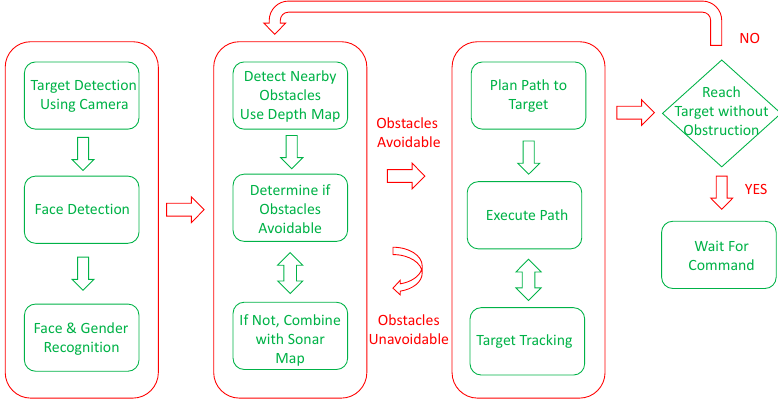
Figure 1. The system flowchart.